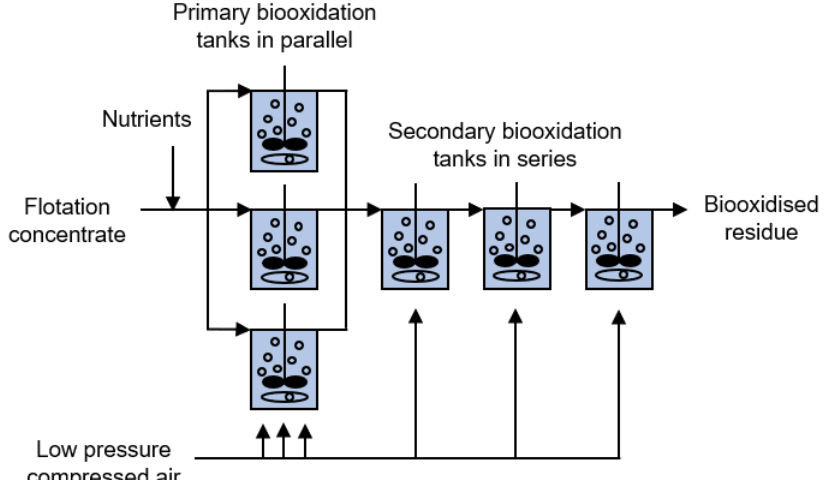
Figure 1. A typical bio-oxidation tank configuration used for sulfidic gold ore concentrates. Adapted from [4].